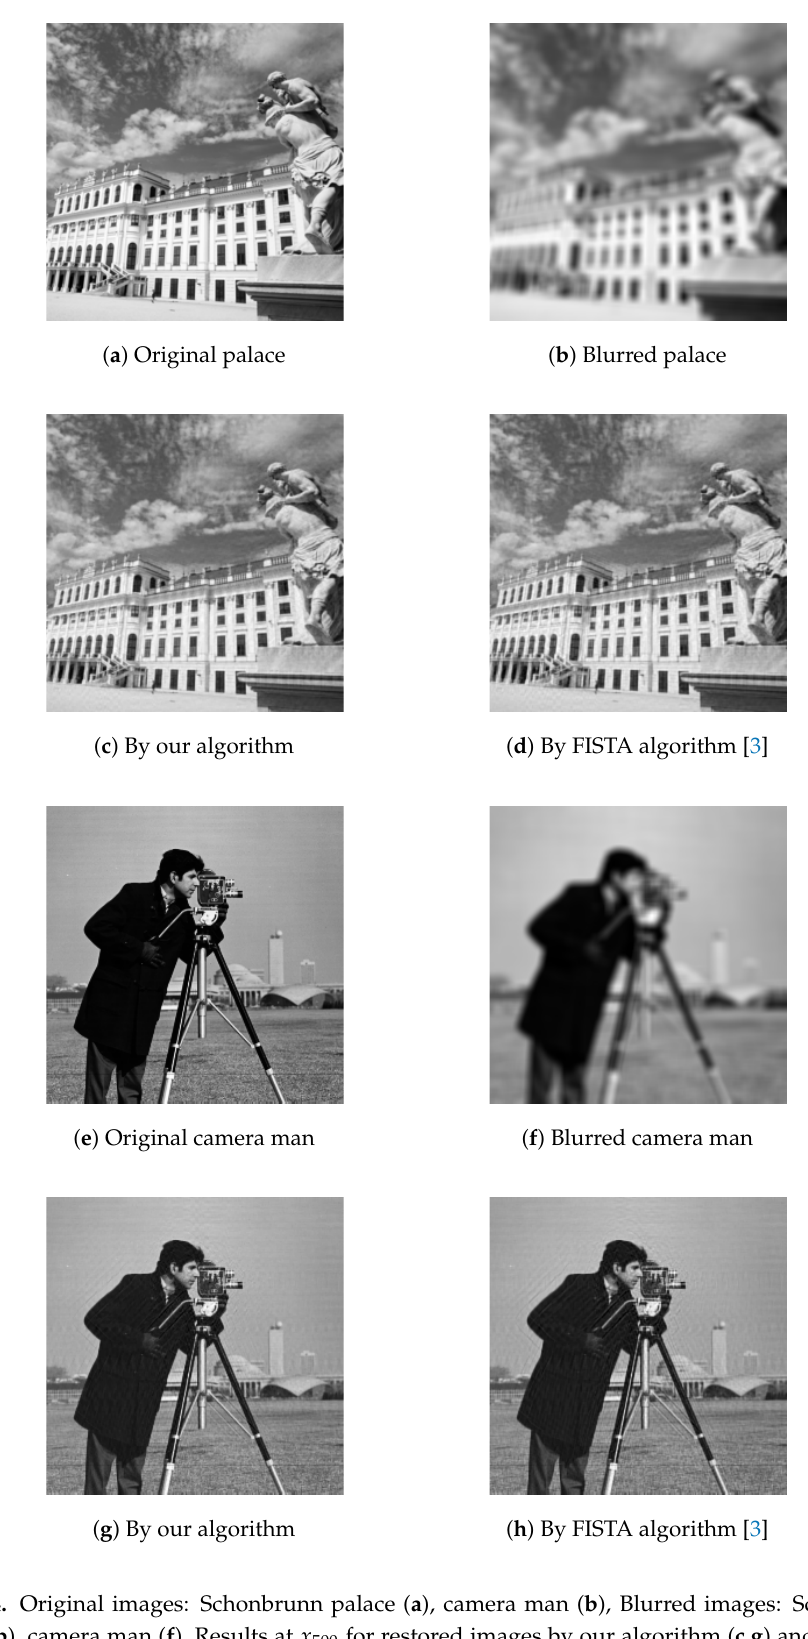
Figure 4. Original images: Schonbrunn palace ( a ), camera man ( b ), Blurred images: Schonbrunn palace ( b ), camera man ( f ), Results at x 500 for restored images by our algorithm ( c , g ) and by FISTA method [3] ( d , h